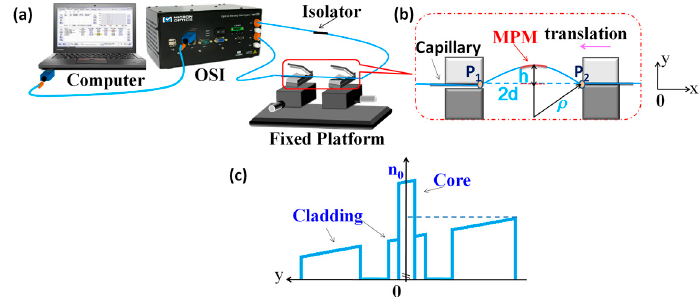
Figure 2. ( a )Schematic diagram of the experimental setup; ( b ) the configuration used for the bending measurements; and ( c ) RI profile of the curved PCF.